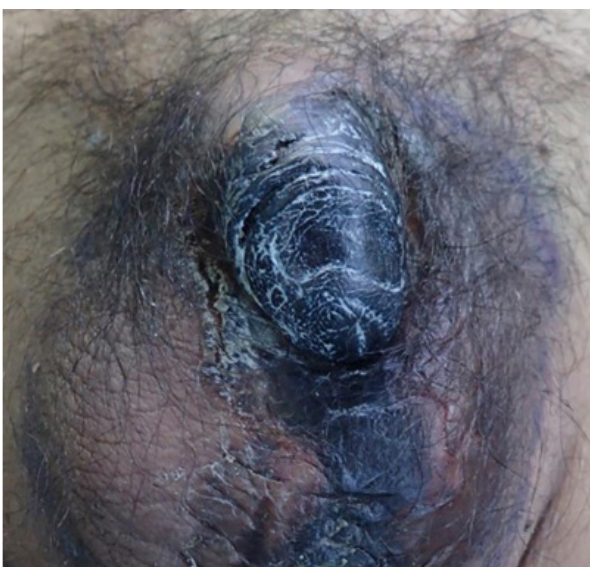
Figure 3: Calcifications in the vascular wall within the gangrenous penile